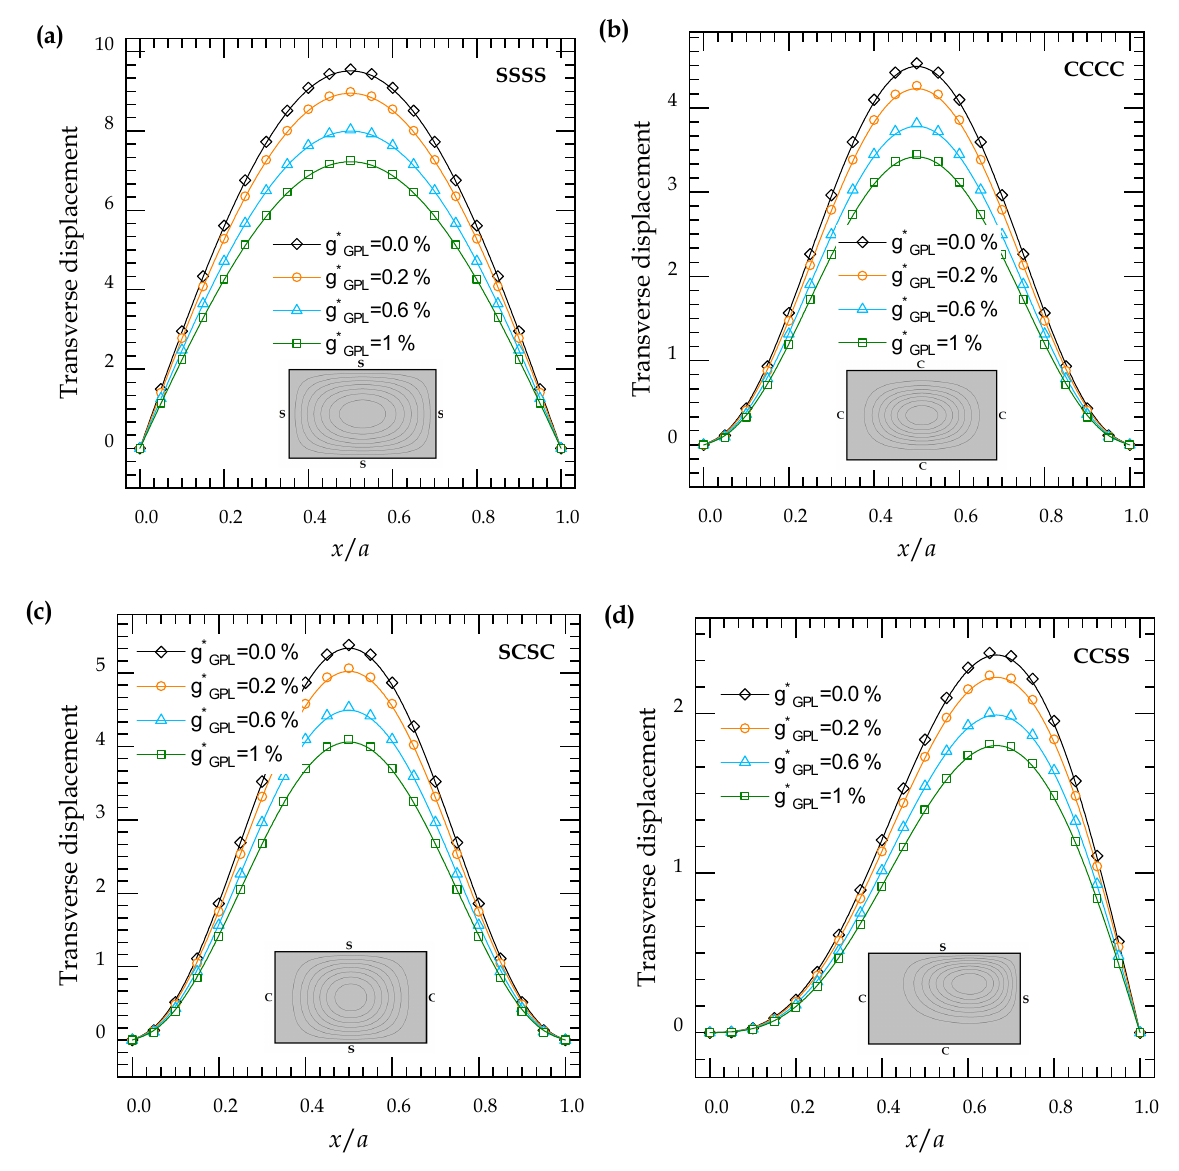
Figure 13. Dimensionless transverse displacement along the x -direction of the GRNC plate for various = 10 ) . ( a ) Full simply supported, ( b ) Full clamped ( b weight fractions g ∗ GPL / a GPL GPL